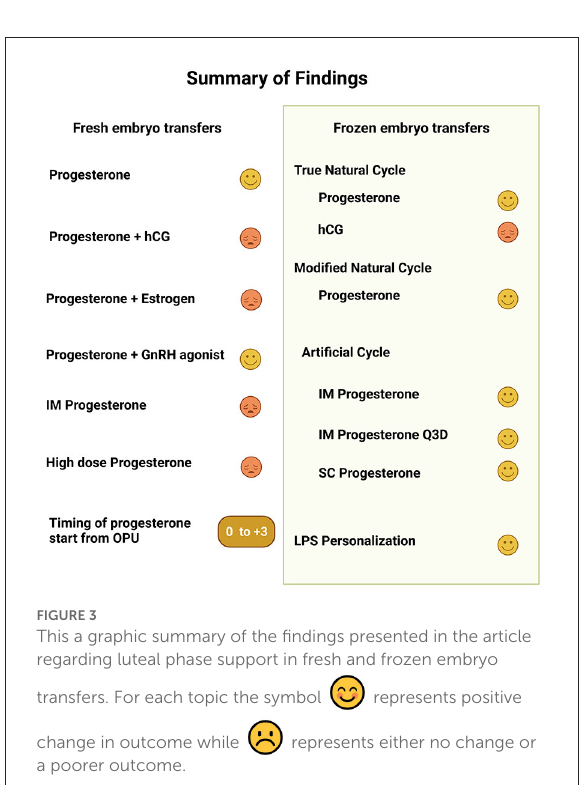
FIGURE3 This a graphic summary of the findings presented in the article regarding luteal phase support in fresh and frozen embryo transfers. For each topic the symbol represents positive change in outcome while represents either no change or a poorer